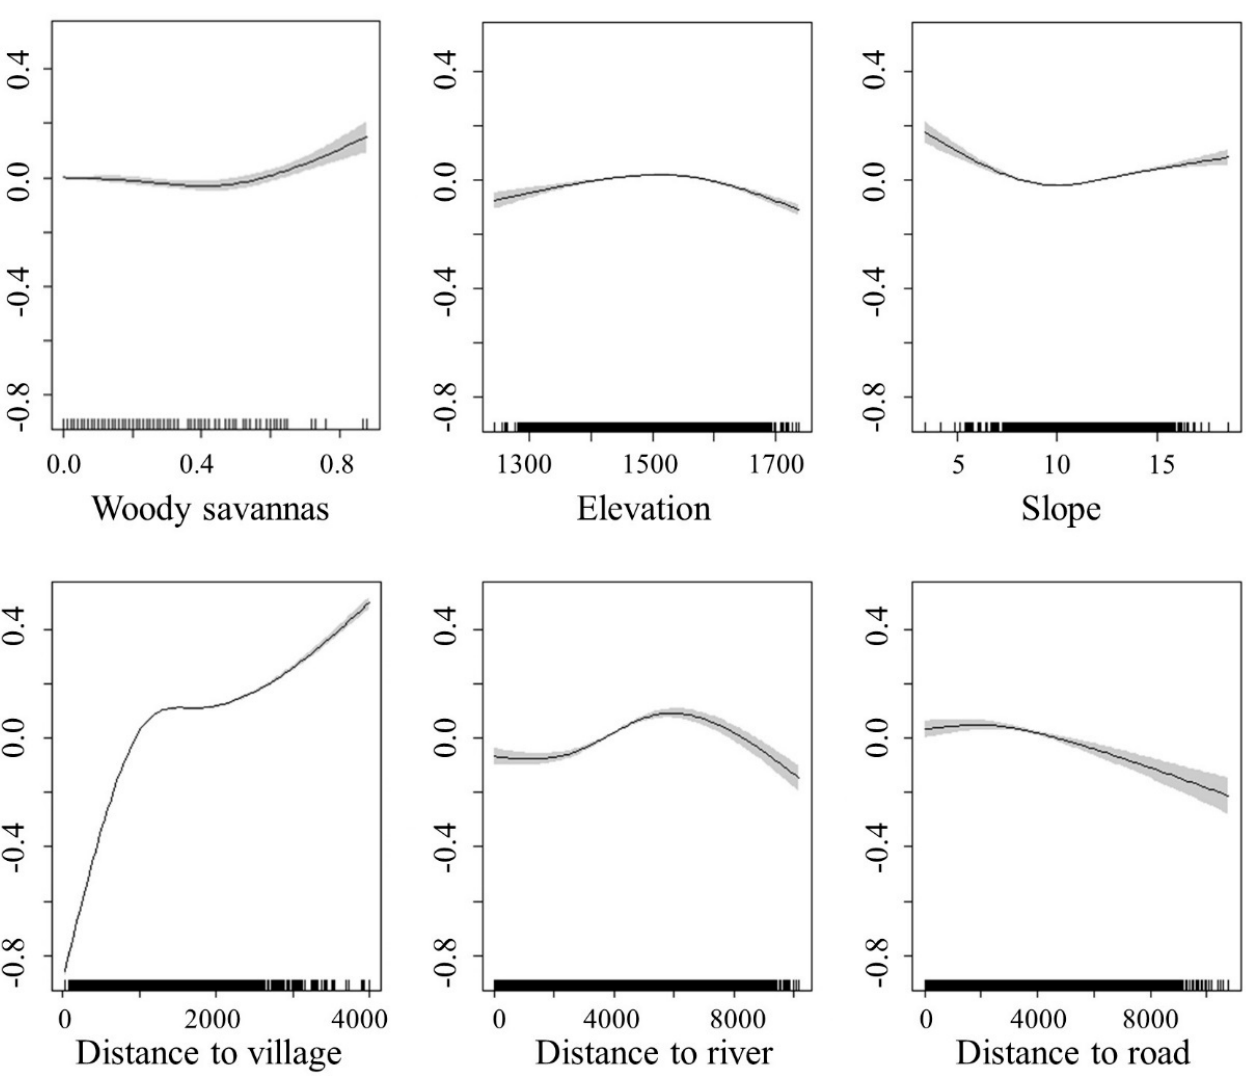
Figure 3. Relationships between the North China leopard density (individuals/0.25 km 2 ) and environmental factors by generalized additive model (GAM). The ordinate shows the estimated population density of North China leopard (individuals/0.25 km 2 ), and the abscissa shows environmental and human factors.